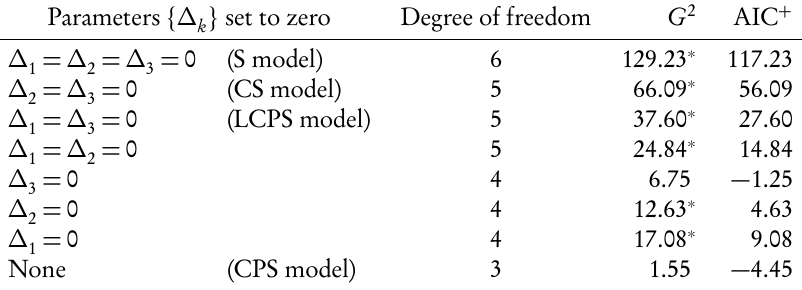
The values of the likelihood ratio chi-square statistic G 2 and the modified Akaike’s information criterion (AIC + ), for the PCPS model applied to the data set of Table